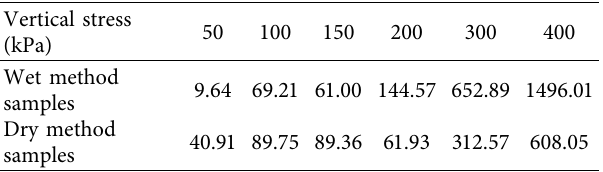
Figure 2: Data distribution of the direct shear test. (a) Wet method samples; (b) dry method samples. Table 5: Shear strength variation of different samples under dif- ferent vertical stress ( × 10 − 2 kPa 2